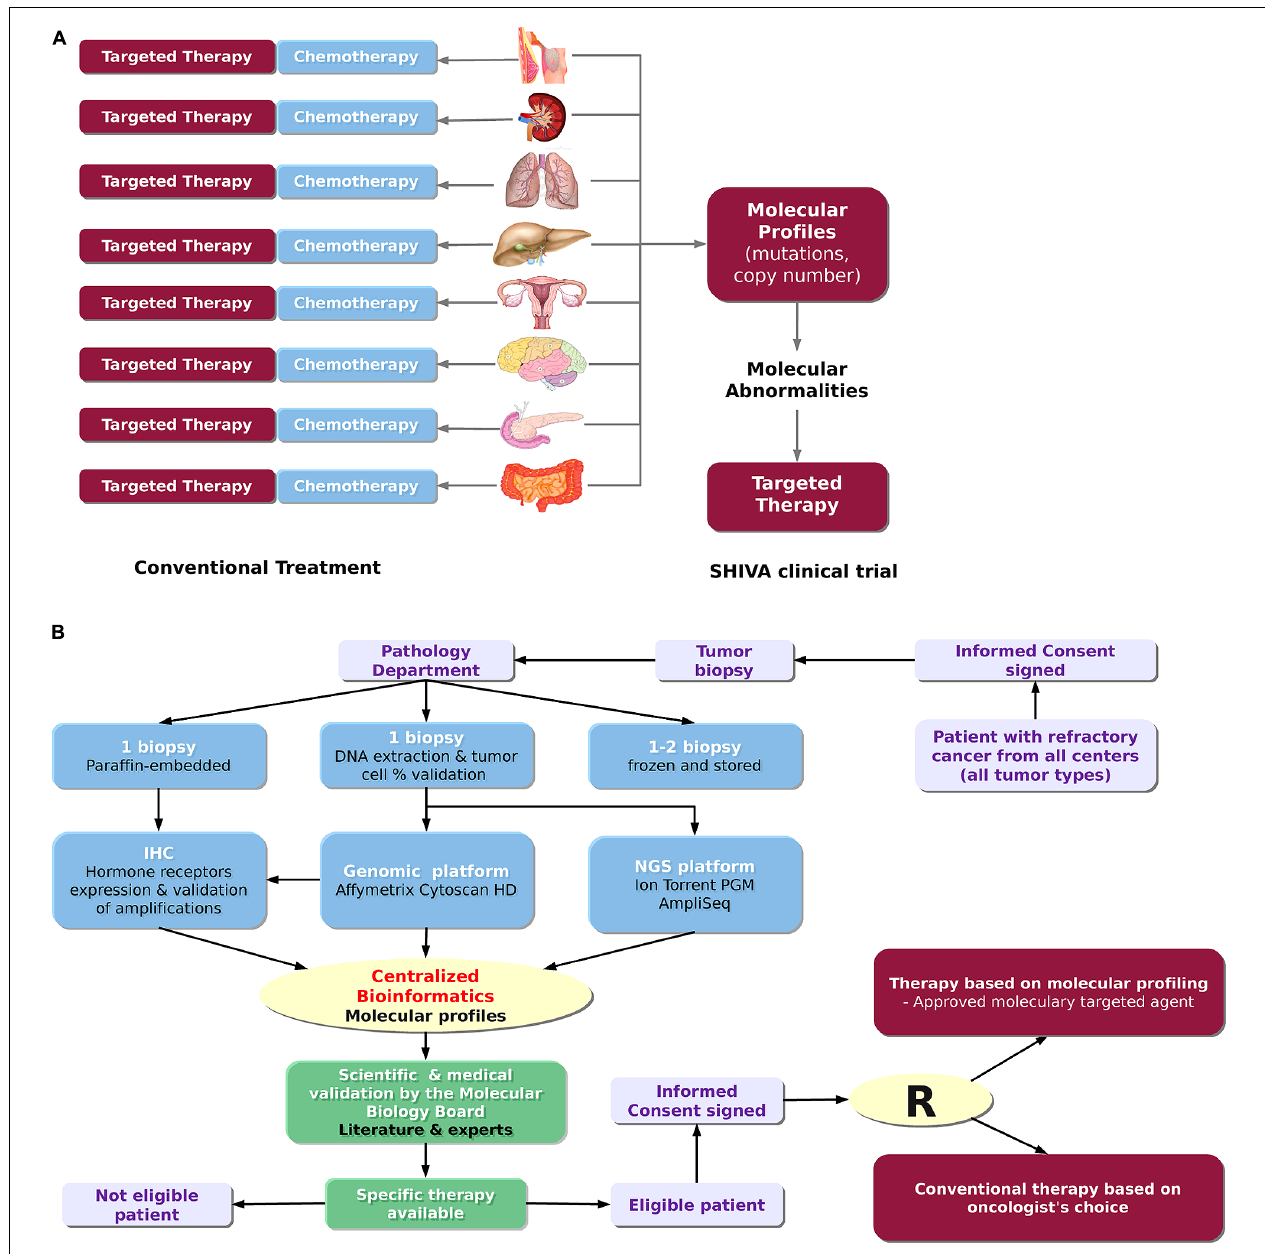
FIGURE 2 |The SHIVA clinical trial. (A) Rationale of the trial.The SHIVA trial aims at determining whether the prescription of molecularly targeted therapies based on tumor molecular abnormalities, independently of primary tumor location and histology, would improve the outcome of cancer patients.